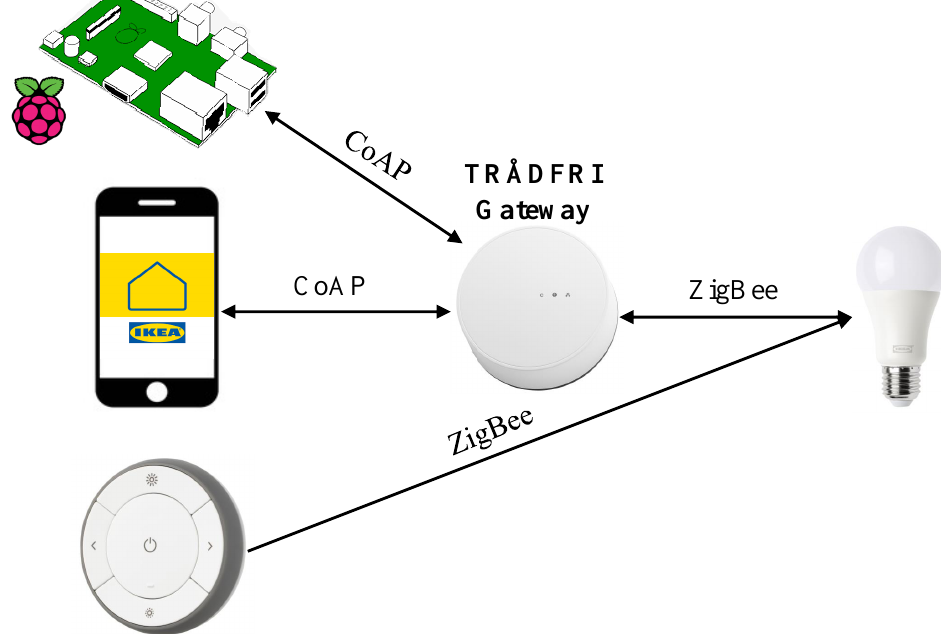
Figure 4. DoS attack